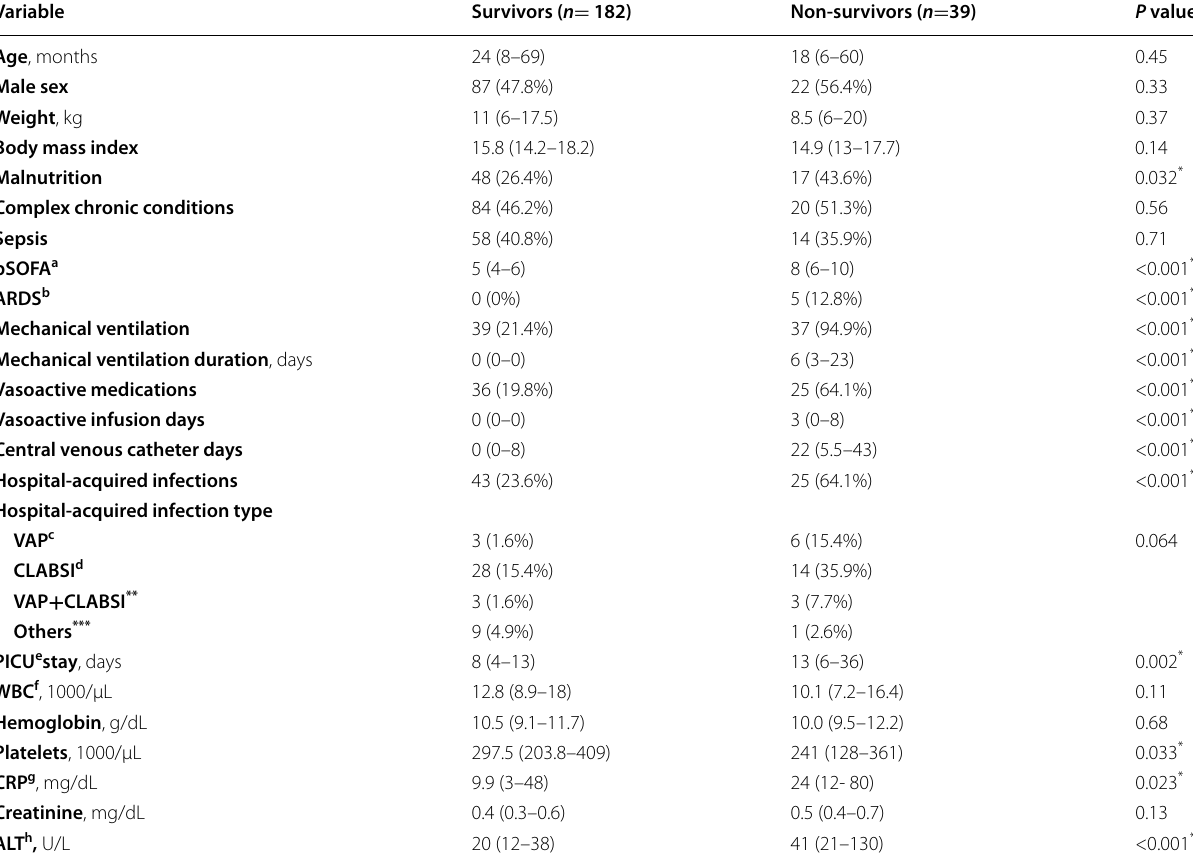
Table 3 General characteristics of survivors and